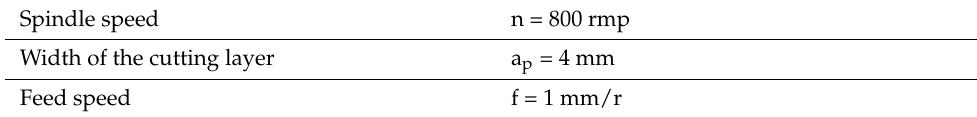
Table 5. Technological parameters of the cutting process—roughing machining. Spindle speed